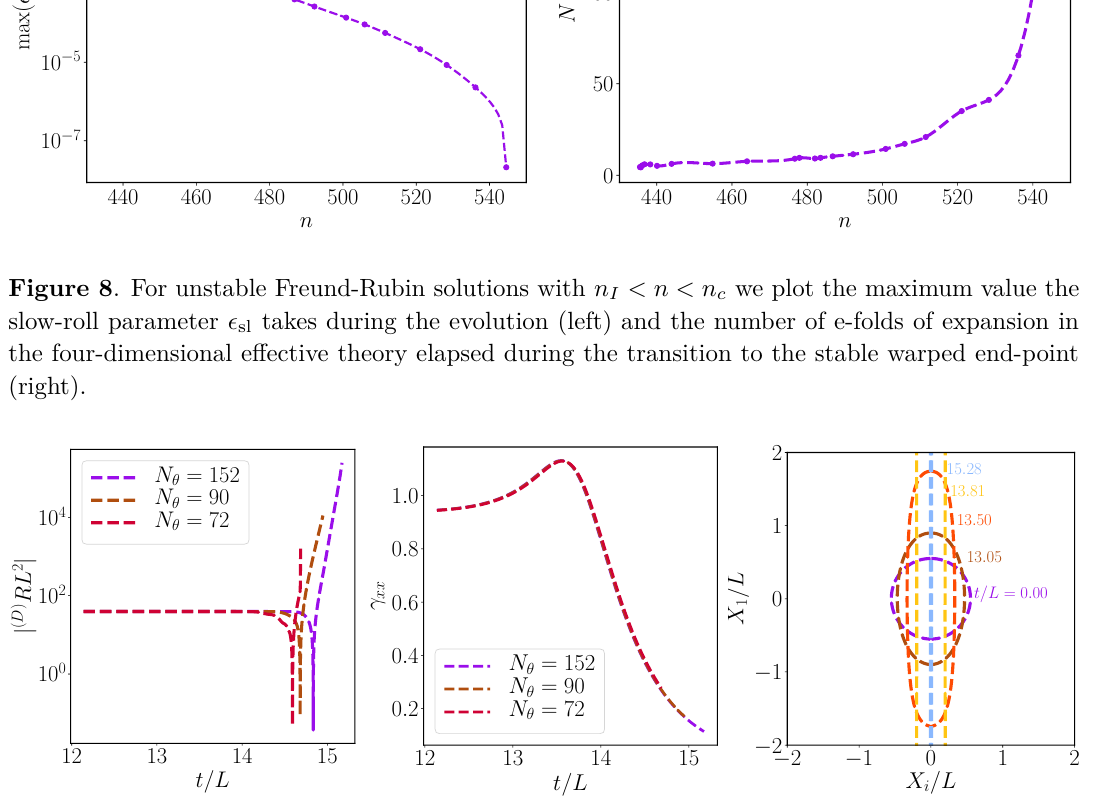
Figure 9 . End state of solution on small volume Freund-Rubin branch with p = q = 4 , Λ D = 1 , n = n Mink and an initial ‘ = 2 perturbation for different resolutions. The D -dimensional curvature scalar which becomes negative at the end (left), scale factor at the equator (middle) and embedding of internal space